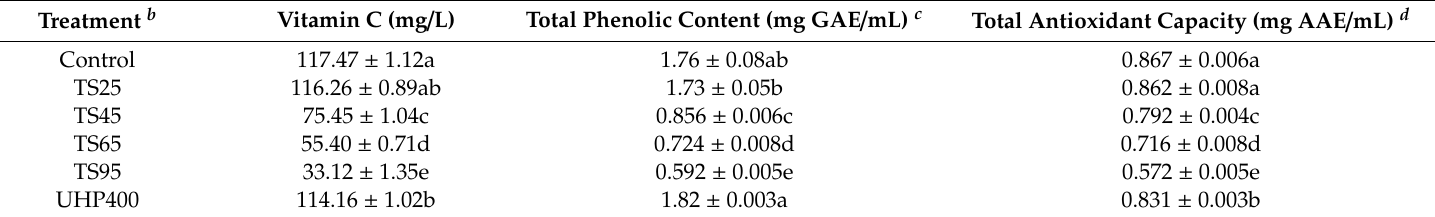
Table 3. E ff ect of di ff erent treatments on antioxidants compounds and antioxidant activity a